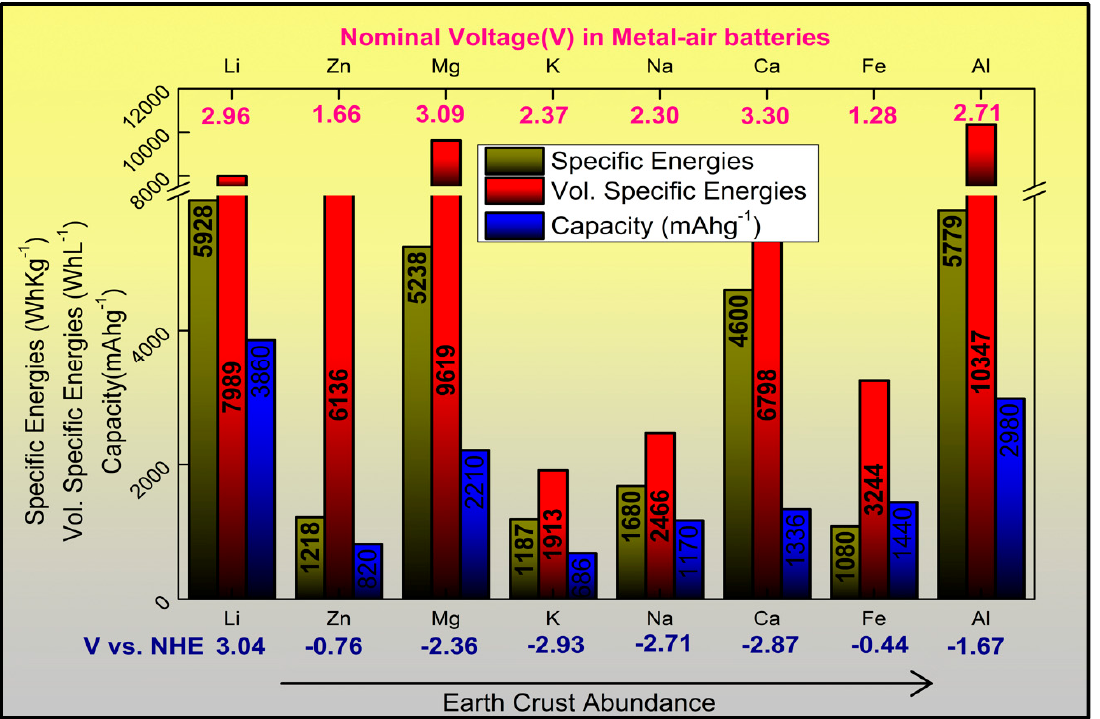
Figure 1. Theoretical gravimetric and volumetric energies, oxygen included, capacities, standard reduction potential vs. normal hydrogen electrode (NHE) and nominal voltages in metal-air batteries of metal negative electrodes used in electrochemical storage systems as well as their earth crust abundance. Adapted from reference [10].